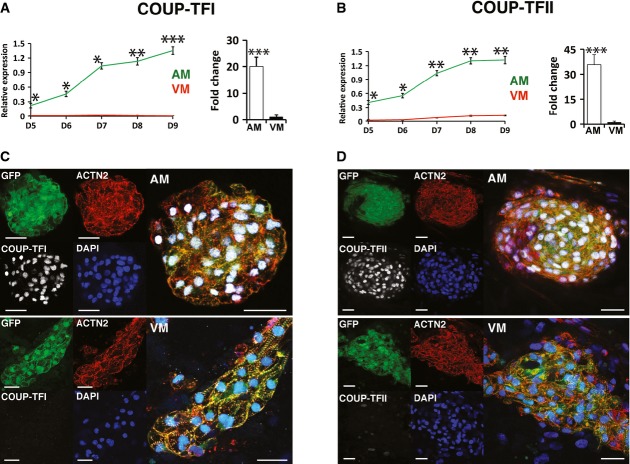
Retinoic acid induces COUP-TFI and COUP-TFII during atrial differentiation
A, B Line plot illustrating relative mRNA levels of (A) COUP-TFI and (B) COUP-TFII in VM and AM differentiations from day 5 through day 9 (left) and in GFP+ CMs at day 31 (right); n = 3.

C, D COUP-TFI (C) and COUP-TFII (D) immunofluorescence at day 31 in AM (top) and VM (bottom). Scale bars: 40 μm.

Data information: Data are presented as mean ± SEM. In (A, B), *P < 0.05, **P < 0.01, ***P < 0.001 by unpaired t-test. In (A), left panel, P = 0.03, 0.02, 0.03, 0.005 and 0.0004 for comparison of COUP-TFI expression between AM and VM at days 5, 6, 7, 8 and 9 of differentiation. In (A), right panel, P = 0.0002 for comparison of COUP-TFI expression at day 31 between AM and VM. In (B), left panel, P = 0.02, 0.03, 0.006, 0.004 and 0.003 for comparison of COUP-TFII expression between AM and VM at days 5, 6, 7, 8 and 9 of differentiation. In (B), right panel, P = 0.0001 for comparison of COUP-TFII expression at day 31 between AM and VM. CT = control differentiation; hESC-atrial (AM); hESC-ventricular (VM).